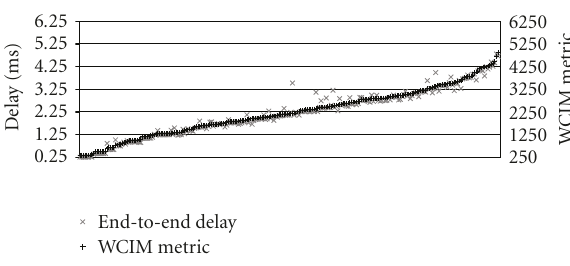
Figure 15: Comparison of ILA metric and end-to-end delay variations ( f 6).